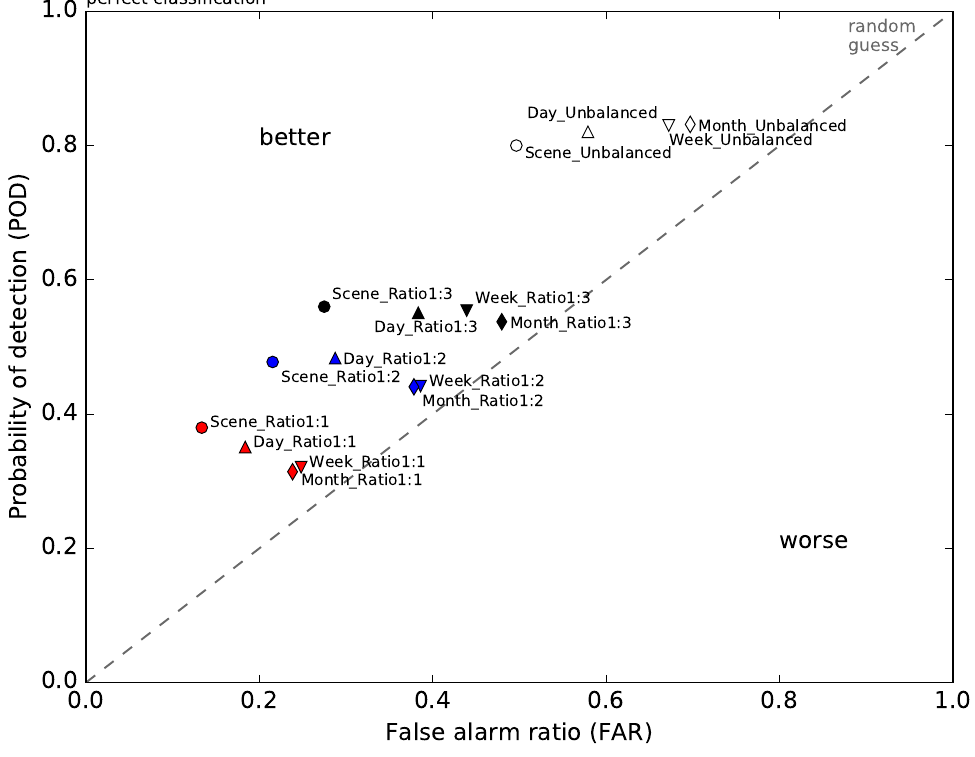
Figure 5. Receiver Operating Characteristics (ROC) diagram comparing the probability of detection (POD) with the false alarm ration (FAR) based on the mean prediction samples of all test weeks in 2017. The colors / shape indicate the different temporal resolutions/different balanced data